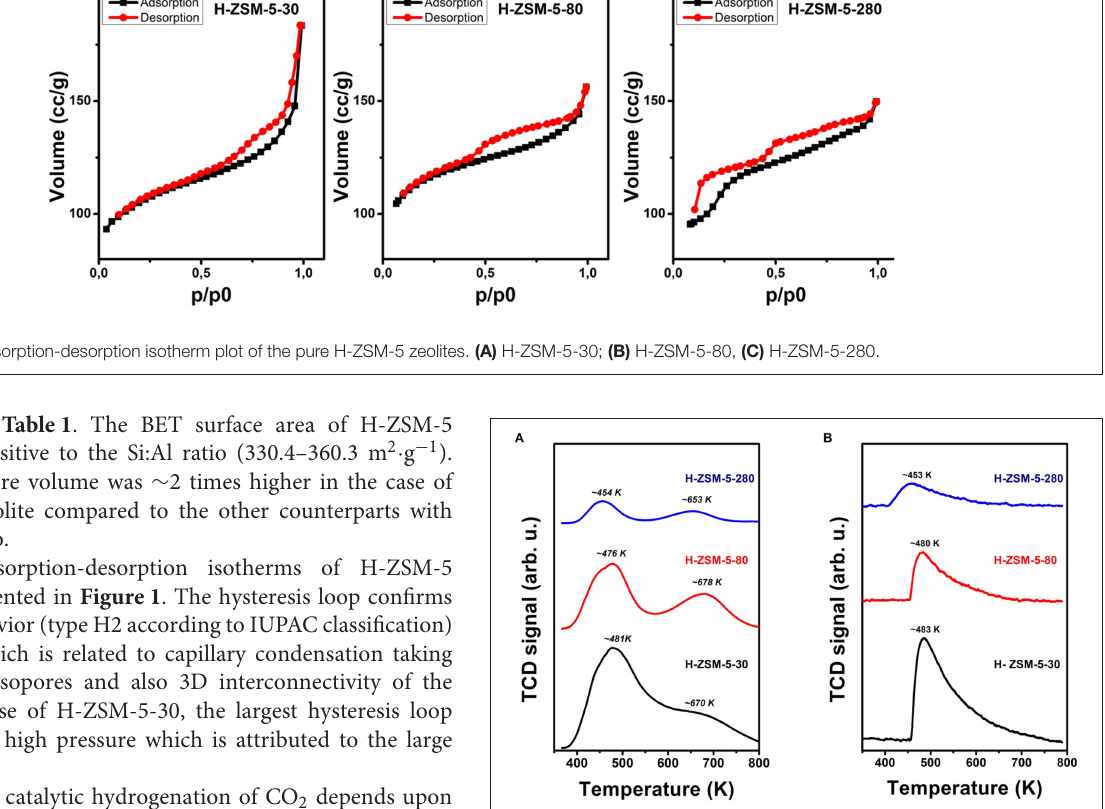
FIGURE 2 | Temperature programmed desorption (TPD) of the H-ZSM-5 catalysts; (A) TPD of ammonia, (B) TPD of CO 2